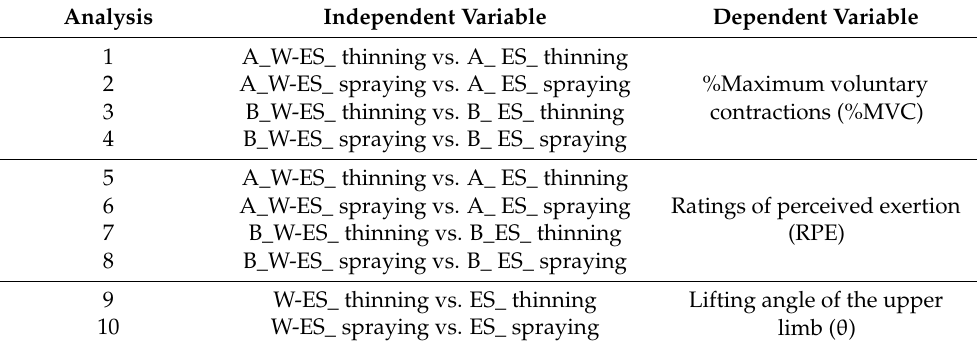
Table 2. One-way ANOVA was performed for each of the conditions being analyzed (A: group A, B: group B, W-ES: Without PULE, ES: With PULE).